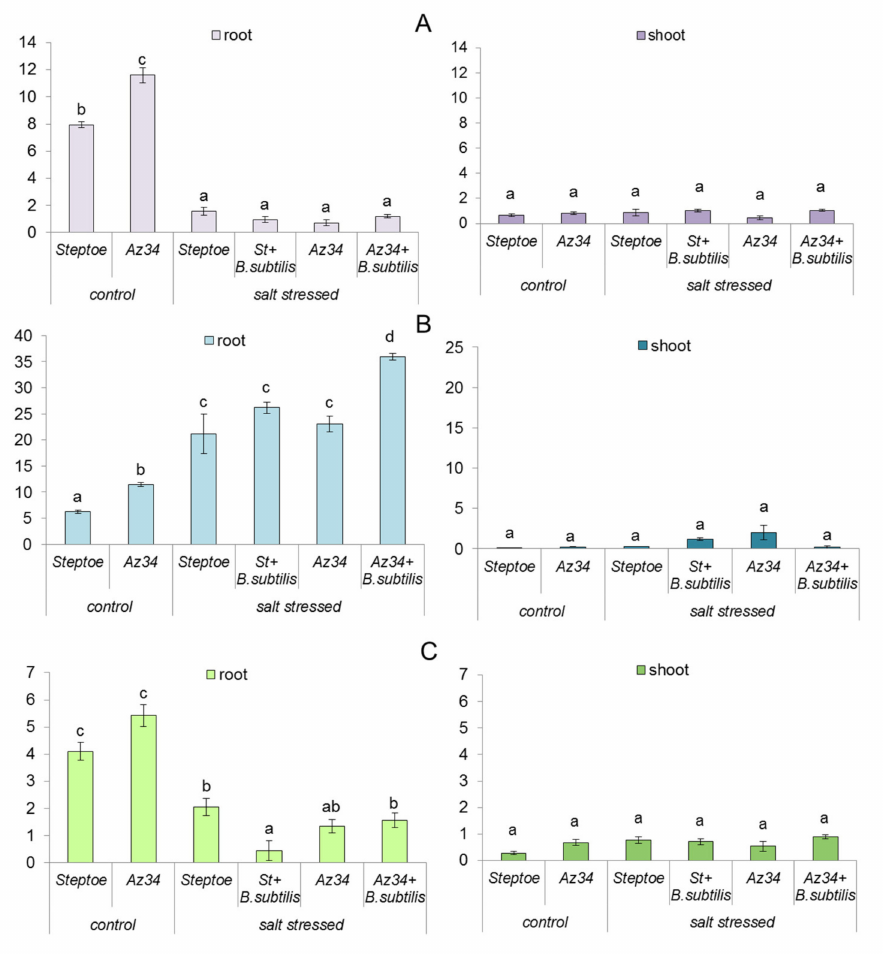
Figure 4. Effect of bacterial treatment of B. subtilis IB-22 on the content of transcripts of genes HvNCED1 ( A ), HvNCED2 ( B ), and HvCYP707A1 ( C ) in roots and shoots of control (unstressed) and salt-stressed (100 mM NaCl) ABA-deficient barley mutant (Az34) and its parental cultivar Steptoe measured on the 7th day after bacterial treatment. The expression values of genes responsible for ABA metabolism in barley are normalized relative to the barley gene HvGADPH , encoding glyceraldehyde 3-phosphate dehydrogenase. Significantly different means for each gene are labeled with different letters ( n =